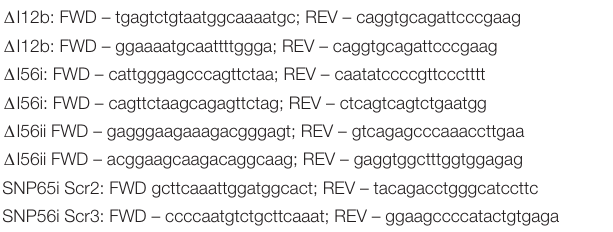
TABLE 1 | Primers used for